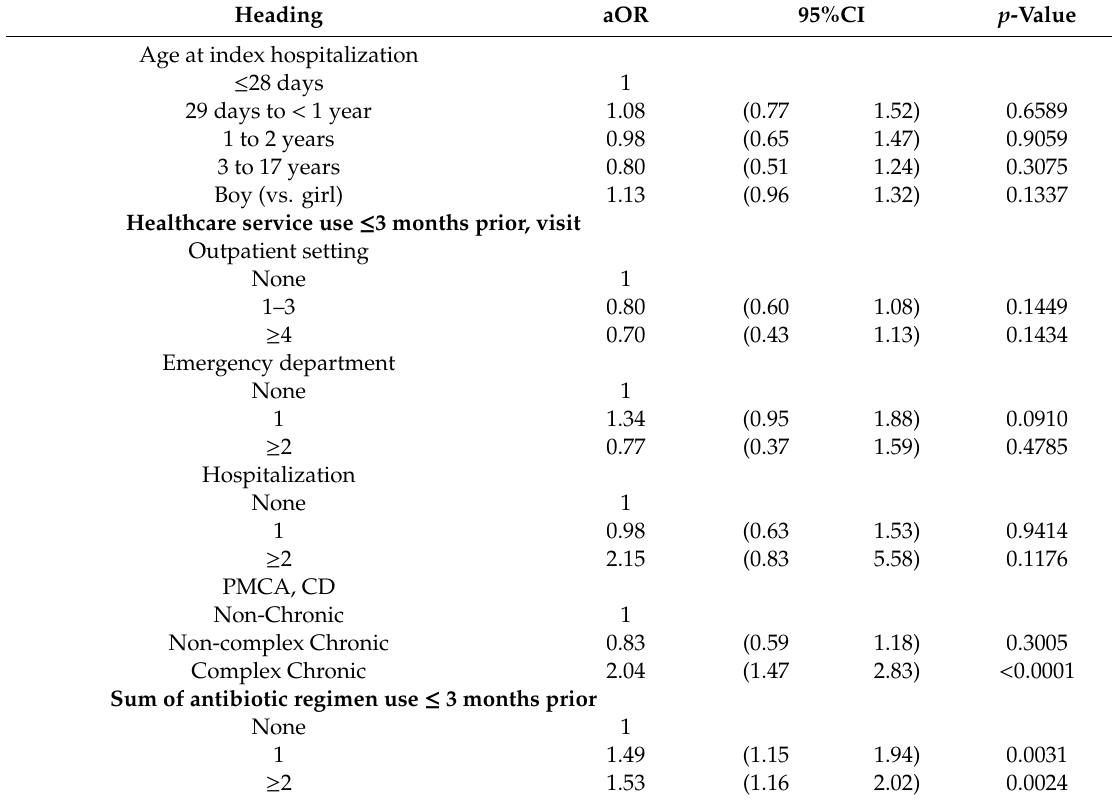
Table 3. Factors associated with third-generation cephalosporin resistance of E. coli in the community- associated UTI